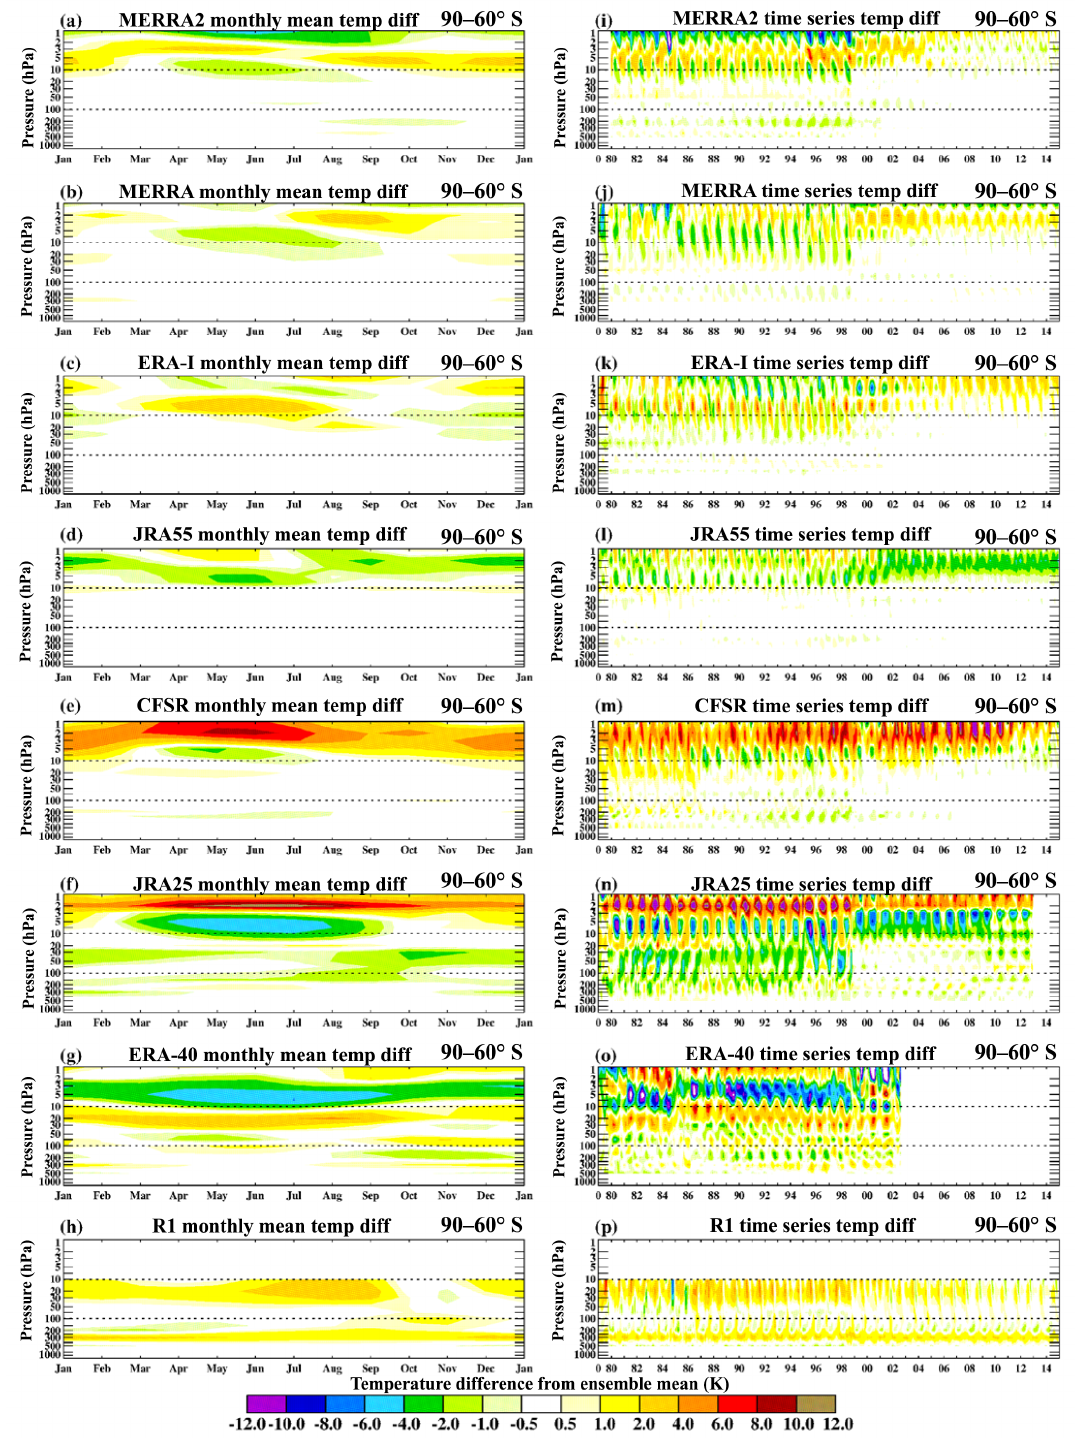
Figure 6. Pressure vs. month plots (a–h) and pressure vs. time plots (i–p) of the temperature difference (K) in individual reanalyses from the REM for the zonal region 90–60 ◦ S. The reanalyses are (a, i) MERRA-2, (b, j) MERRA, (c, k) ERA-I, (d, l) JRA-55, (e, m) CFSR, (f, n) JRA-25, (g, o) ERA-40, and (h, p) R1. The left column plots are the monthly mean differences for the entire 1979–2014 period. The right column plots are each month’s difference from the REM for that same